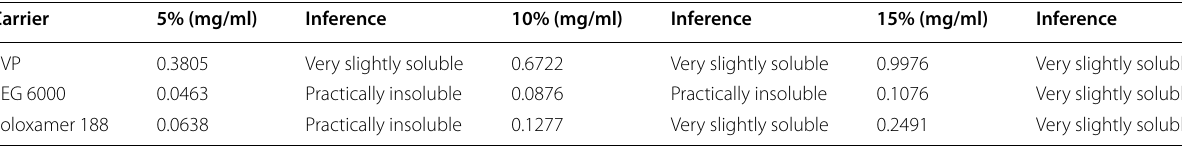
Table 3 Phase solubility study of drug with aqueous solution of carrier Carrier